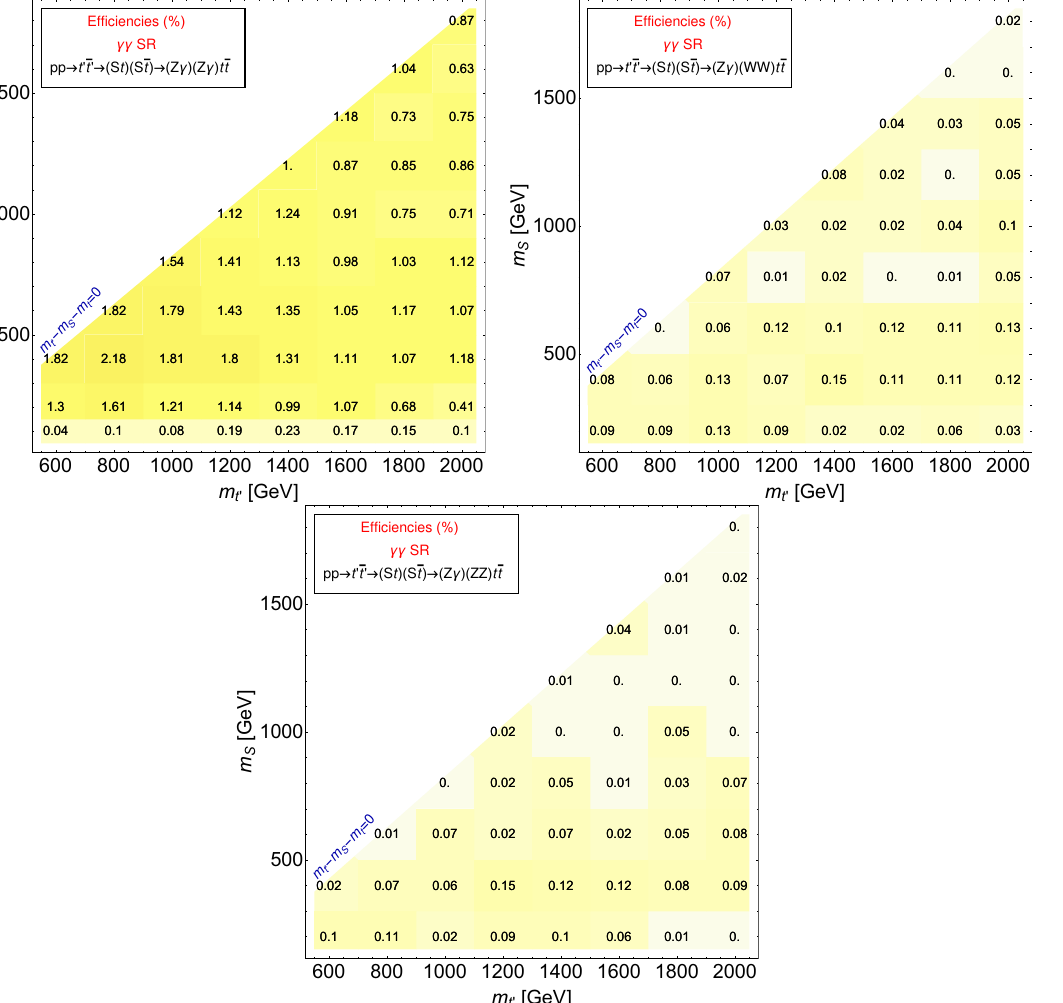
Figure 19 . E(cid:14)ciencies for the (cid:13) (cid:13) SR and for channels where at least one of the two S decays into Z (cid:13)